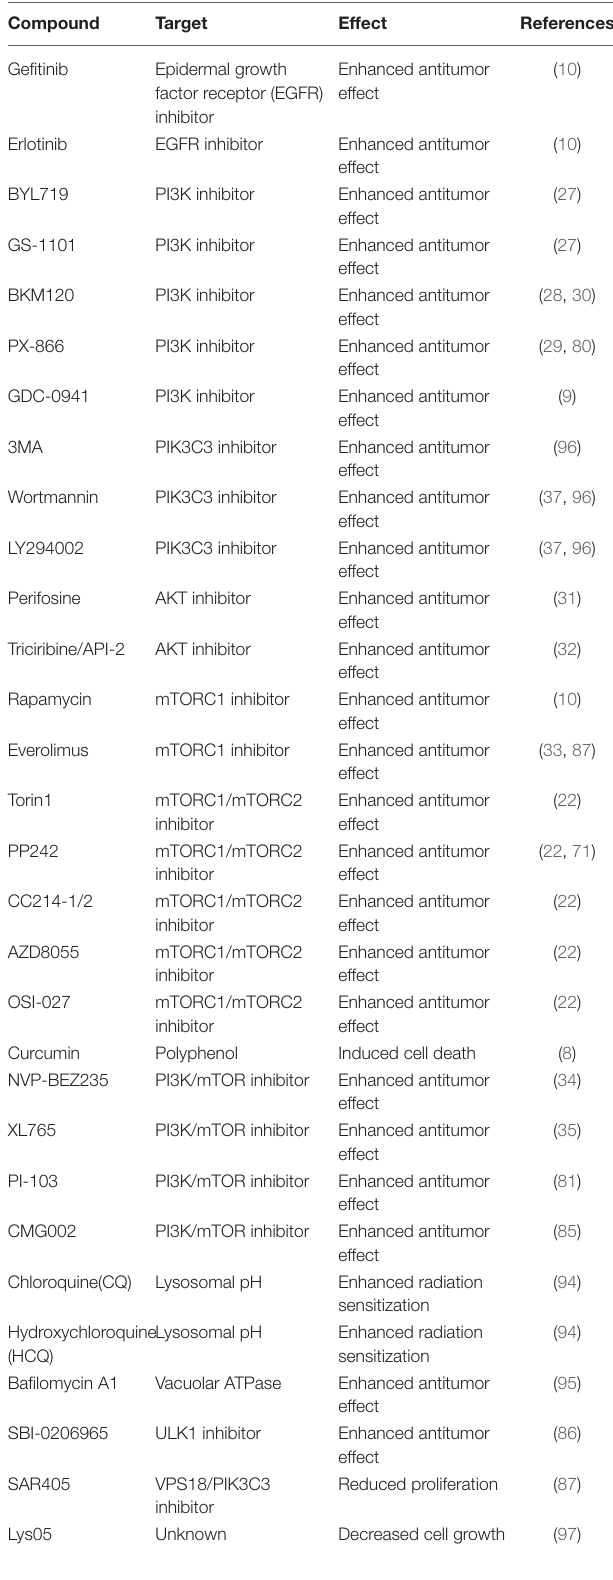
TABLE 1 | Therapeutic agents regulate phosphoinositide 3-kinase (PI3K)/protein kinase B (AKT)/mammalian target of rapamycin (mTOR) pathway or autophagy for glioblastoma (GB)